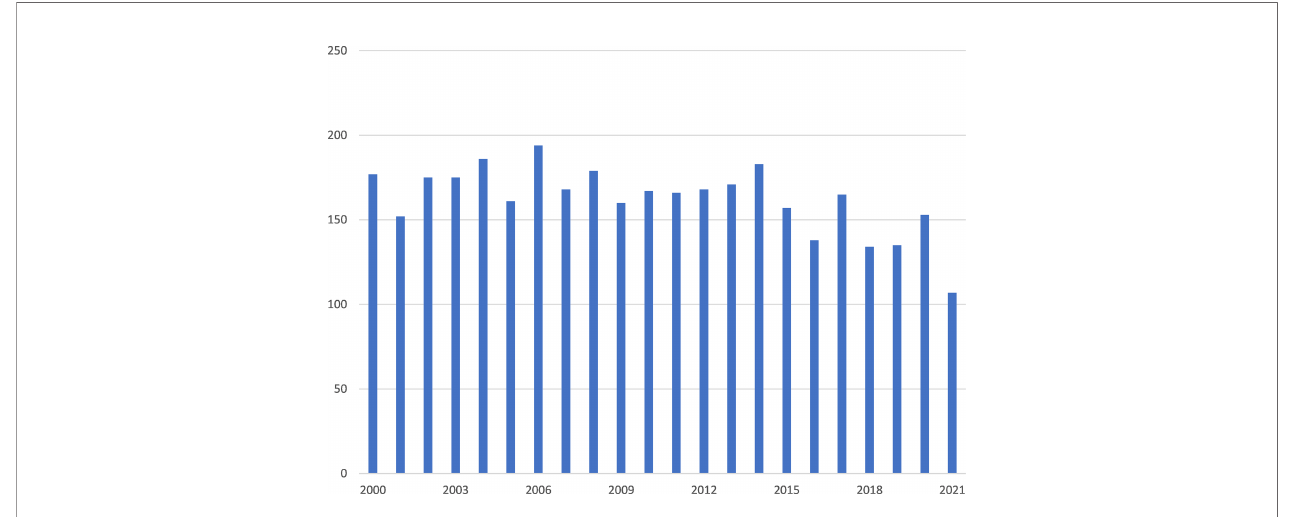
FIGURE 1 | PubMed search results: articles per